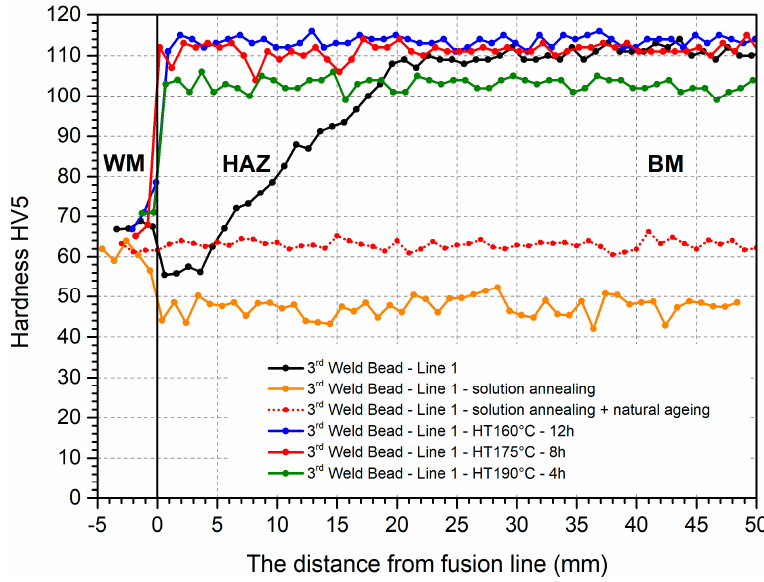
Figure 14. Measured hardness values in three-pass weld in the zone of line 1 after welding with preheating temperature of 75 °C and after different types of heat treatment.